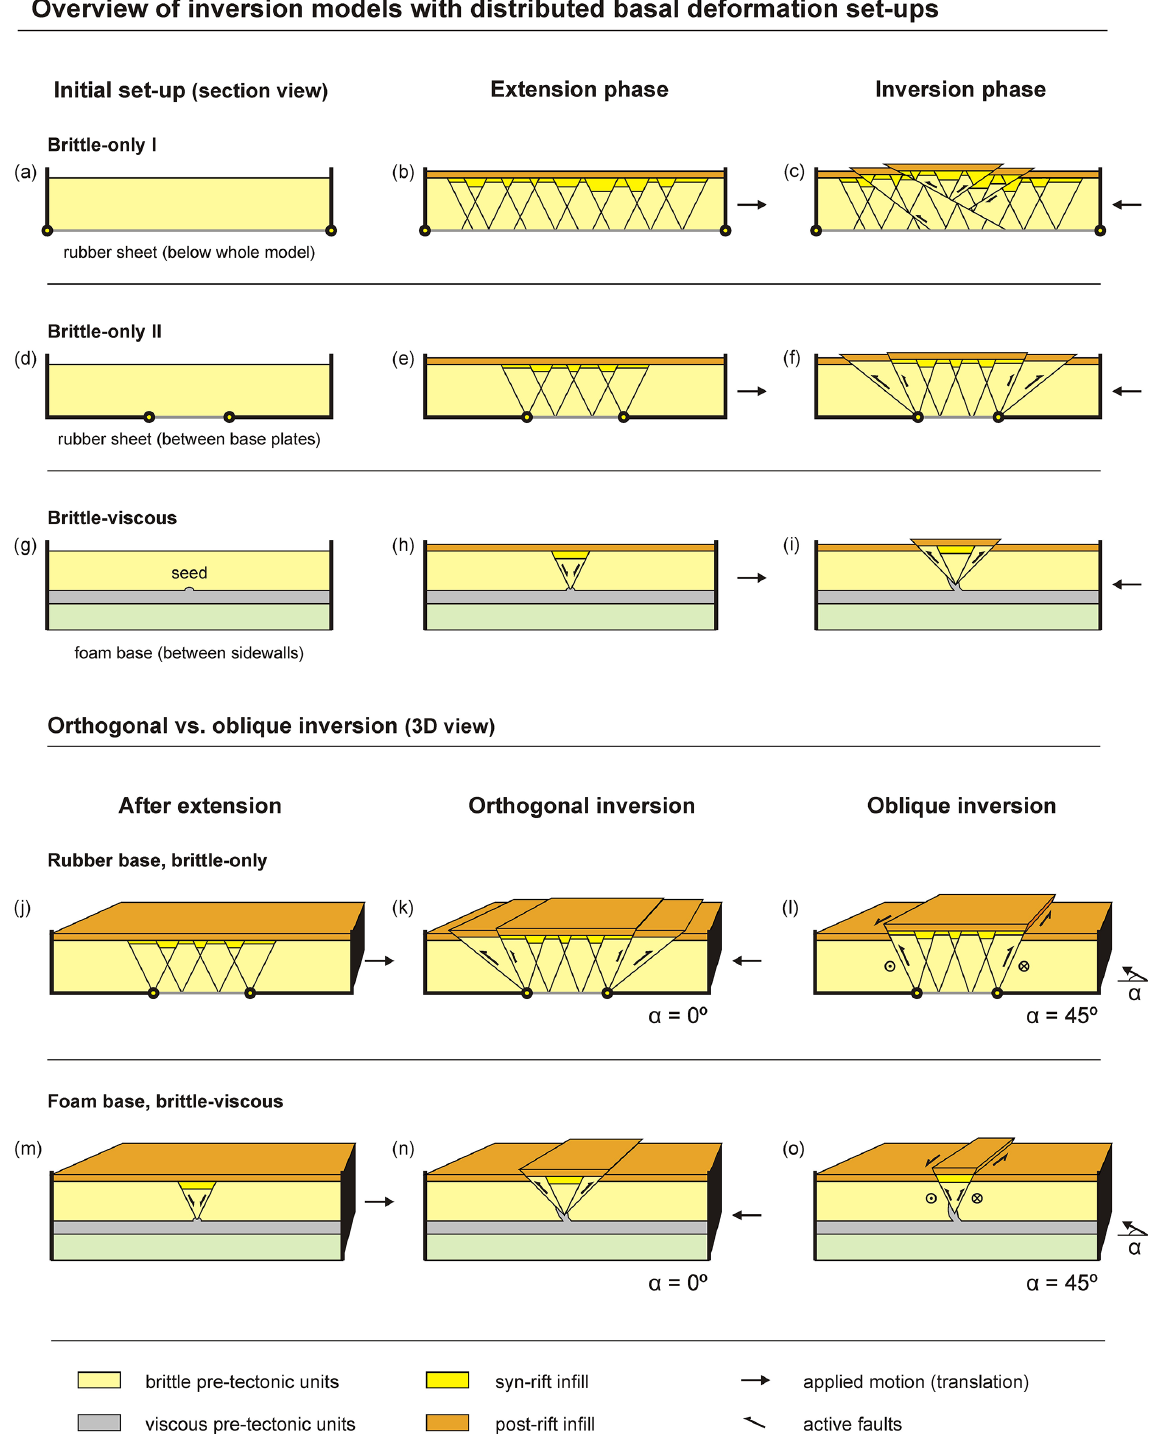
Figure 13. Sketches of representative results from brittle-only basin inversion models involving a set-up with distributed deformation at the base. (a–c) Brittle-only inversion experiment with a rubber base below the whole model. (d–f) Brittle-only inversion experiment with a rubber sheet spanned between two base plates. (g–i) Brittle–viscous inversion models with a foam base set-up. (j–o) The 3D effect of inversion direction on reactivation of pre-existing faults; oblique compression promotes oblique-slip reactivation of steep normal faults that are unlikely to be reactivated in an orthogonal compression situation. This effect is also observed in the brittle–viscous inversion models with a foam base. Images inspired by McClay (1989), Amilibia et al. (2005), and Richetti et al. (2022).